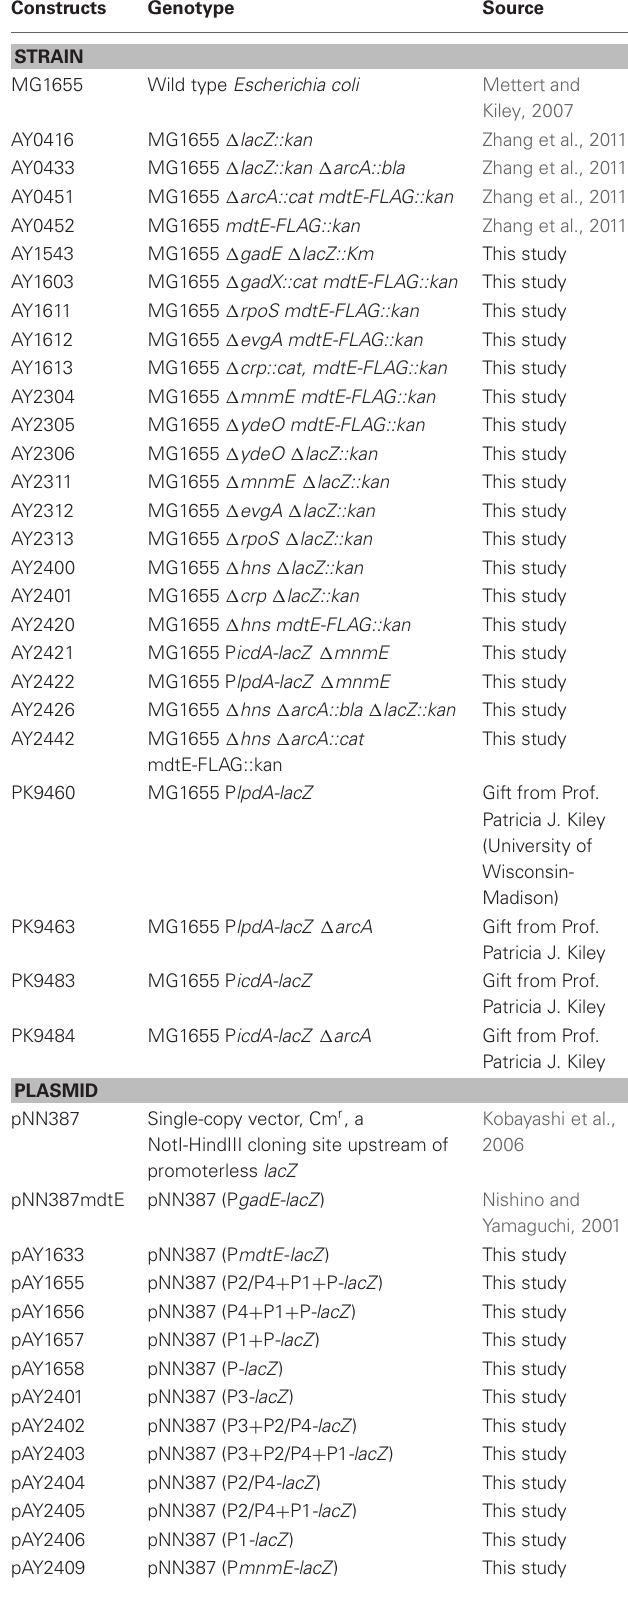
Table 1 | Bacterial strains and plasmids used in this study.